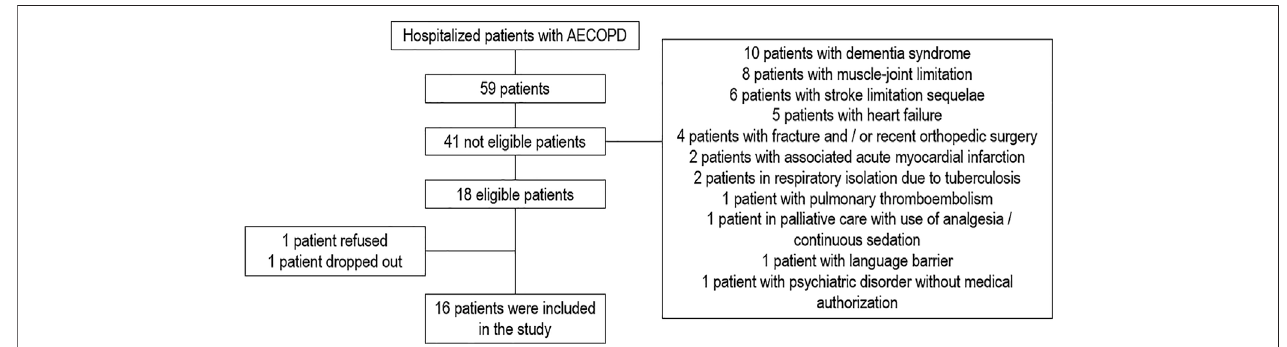
FIGURE 2 | Screening fl owchart for hospitalized patients with AECOPD. Abbreviations: AECOPD, acute exacerbation of COPD.